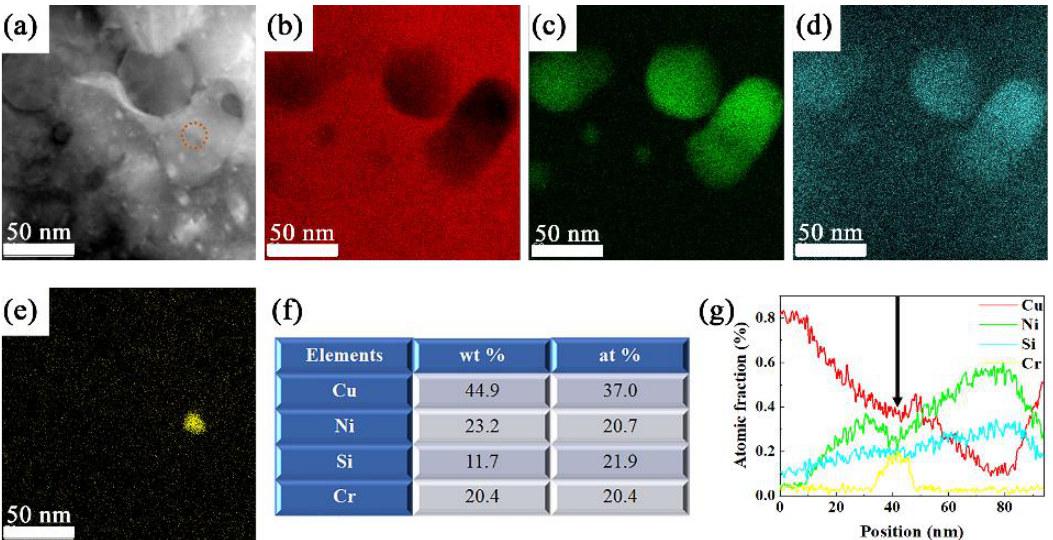
Figure 9. The TEM photographs showing the Ni-Si enriched precipitates in ( a ), the corresponding elements distribution of ( b ) Cu, ( c ) Ni, ( d ) Si and ( e ) Cr, and the EDS data ( f ) of the precipitate marked by orange circle in ( a ), and ( g ) linear distribution of elements as illustrated in black arrowhead in ( a ).